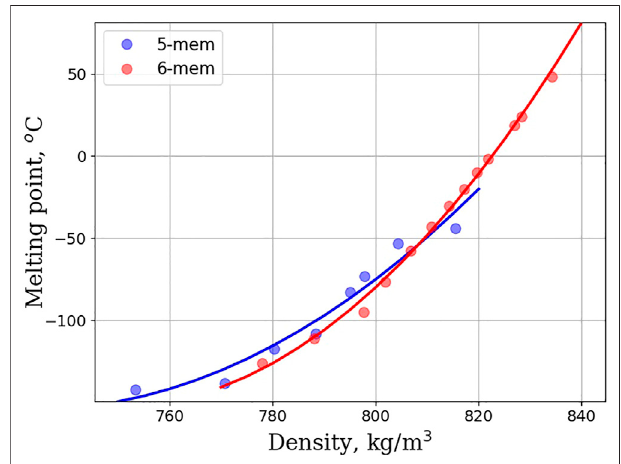
FIGURE 3 | Flashpoint (in degrees Celsius) as a function of energy density (inMJ/Lforunsubstitutedcycloalkanes.Thelineartrendsuggeststhat ring size, fl ashpoint, and energy density are directly correlated.